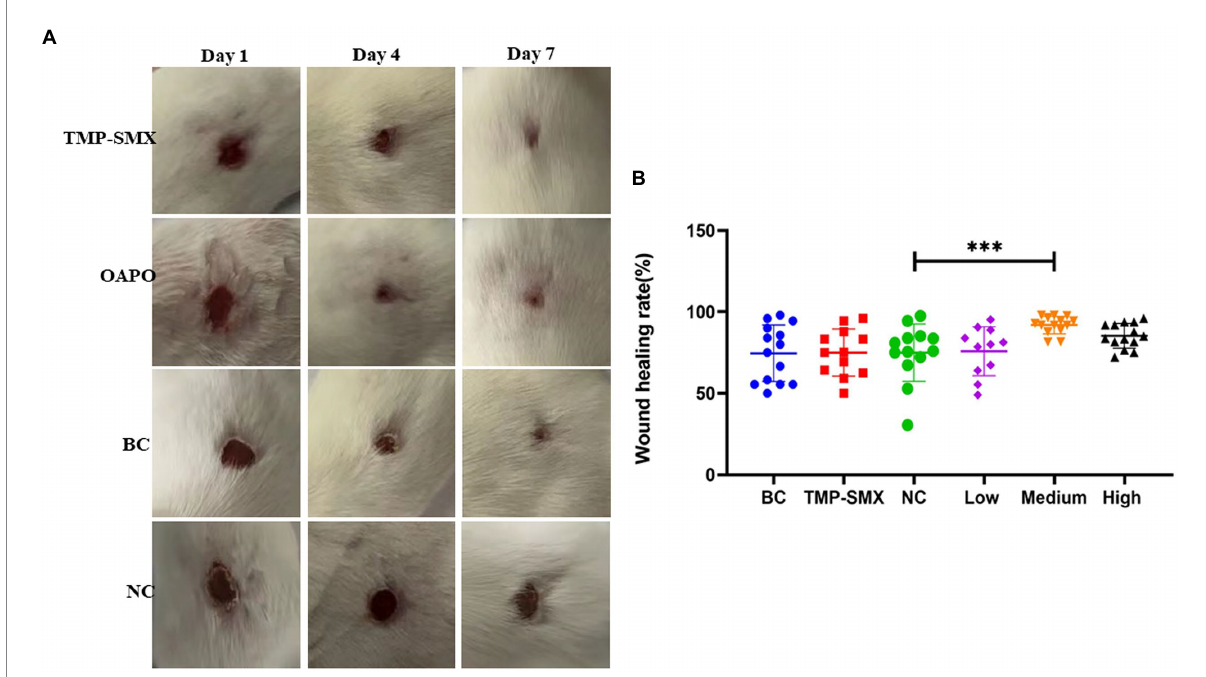
FIGURE 5 Effects of organic acid of Portulaca oleracea L. (OAPO) on skin wound recovery. (A) Skin wound healing appearance of mice on days 1, 4, and 7 post-inoculation with Staphylococcus aureus MRSA85. TMP-SMX: trimethoprim-sulfamethoxazole; OAPO: OAPO medium group; BC: blank group, uninfected, no drug; NC: infected without drug. (B) Scatter diagram of the healing rate of mice on day 7 post-inoculation with S. aureus MRSA85. ***indicates p < 0.001 when compared with the negative control group (NC, infected without